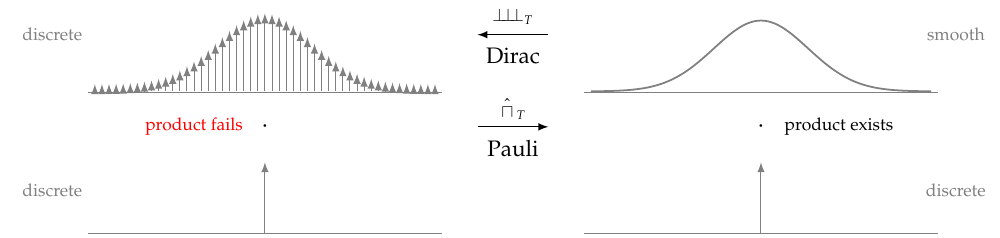
Figure 1. Multiplication products, discrete–discrete fails, discrete–smooth products